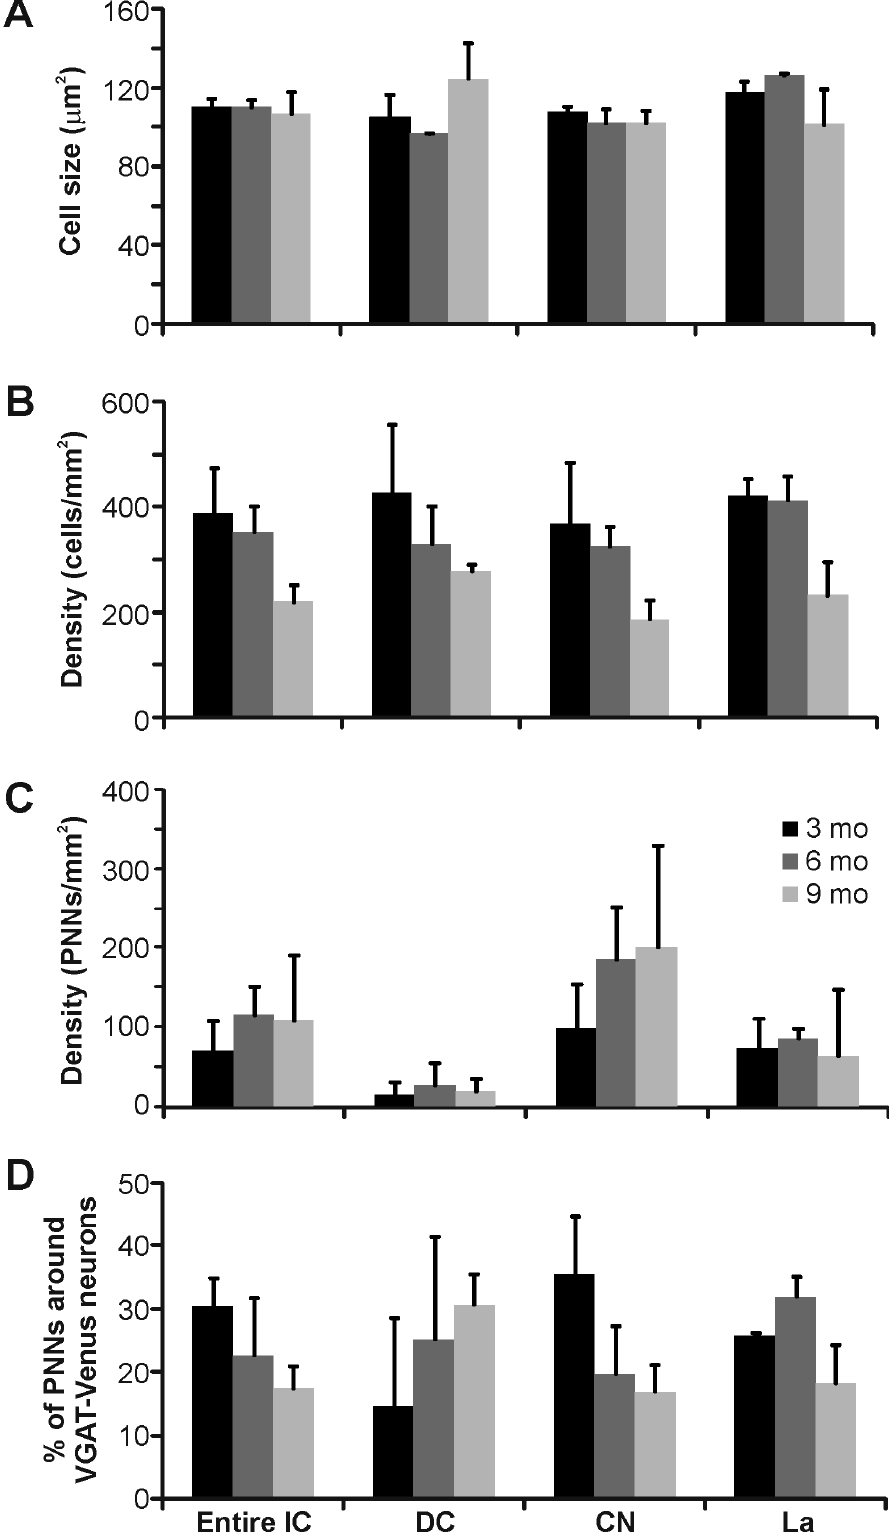
Figure 2. Quantification of Venus-positive and WFA-positive labeling in the inferior colliculus of the vesicular gamma-amino butyric acid transporter (VGAT)-Venus C57BL/6 mouse strain: ( A ) average size of Venus-positive neurons was similar across nuclei; ( B ) density of Venus-positive neurons was less in older animals; ( C ) PNNs were denser in the central nucleus (CN) compared with the dorsal cortex (DC) or lateral nucleus (La); and ( D ) fewer than half of PNNs surrounded VGAT-Venus positive neurons in the IC.